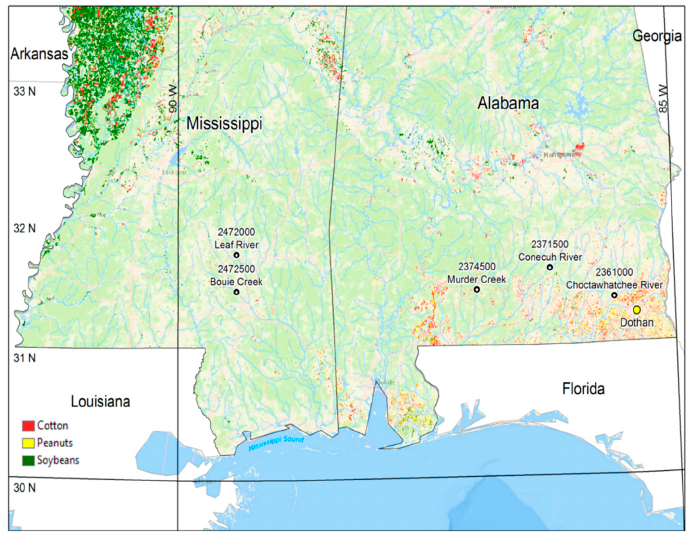
Figure 1. Map of coastal MS-AL showing the location of coastal streamflow gages along with areas where cotton, peanuts, and soybeans are grown. The crop data was acquired from the USDA Cropland Data Layer (2015).